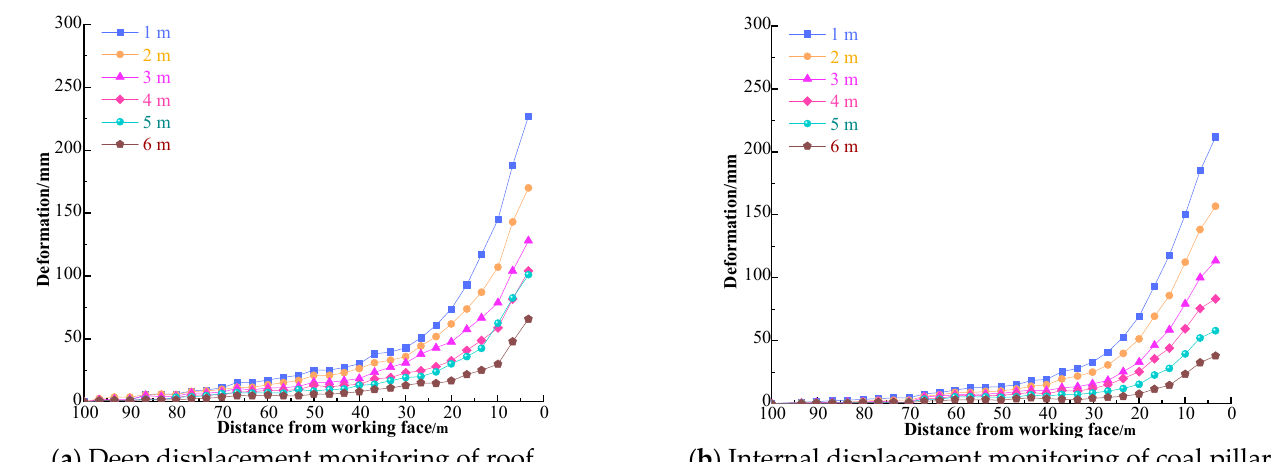
Figure 22. Monitoring of surrounding-rock deformations of gob-side entry-retaining technology.